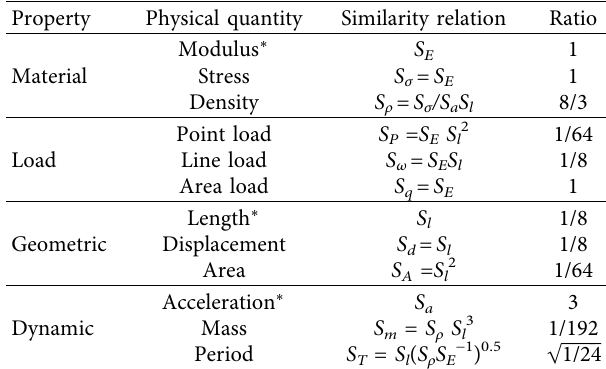
Table 3: Similitude parameters of the shaking table test for 16 and 24m